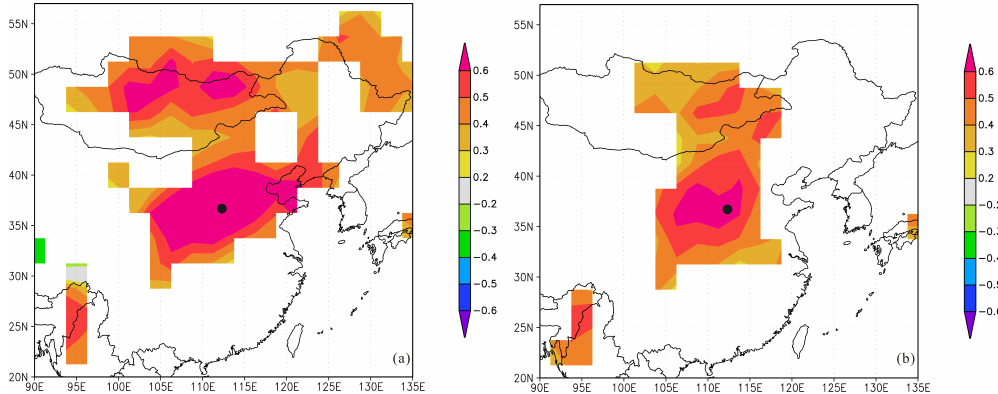
Fig. 3 (a) The regional tree-ring chronology of Lingkong Mountain, (b) number of Fig. 8. Spatial correlations between the Dai (a) and reconstructed (b) PDSI of March–August and the concurrent grid dataset of the PDSI cores and (c) EPS and RBAR statistics. over their overlapping periods (1954–2005) (http://climexp.knmi.nl). The black dot indicates our sampling site.